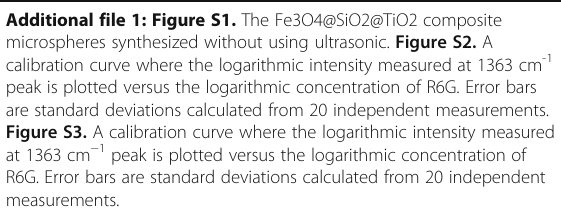
Additional file 1: Figure S1. The Fe3O4@SiO2@TiO2 composite microspheres synthesized without using ultrasonic. Figure S2. A calibration curve where the logarithmic intensity measured at 1363 cm -1 peak is plotted versus the logarithmic concentration of R6G. Error bars are standard deviations calculated from 20 independent measurements. Figure S3. A calibration curve where the logarithmic intensity measured at 1363 cm − 1 peak is plotted versus the logarithmic concentration of R6G. Error bars are standard deviations calculated from 20 independent